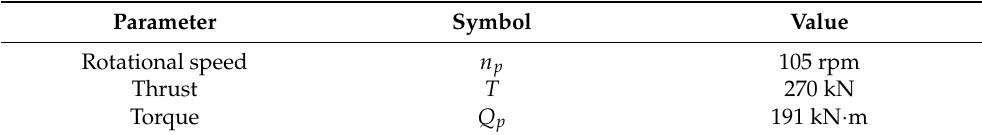
Table 2. Specifications of the propeller.